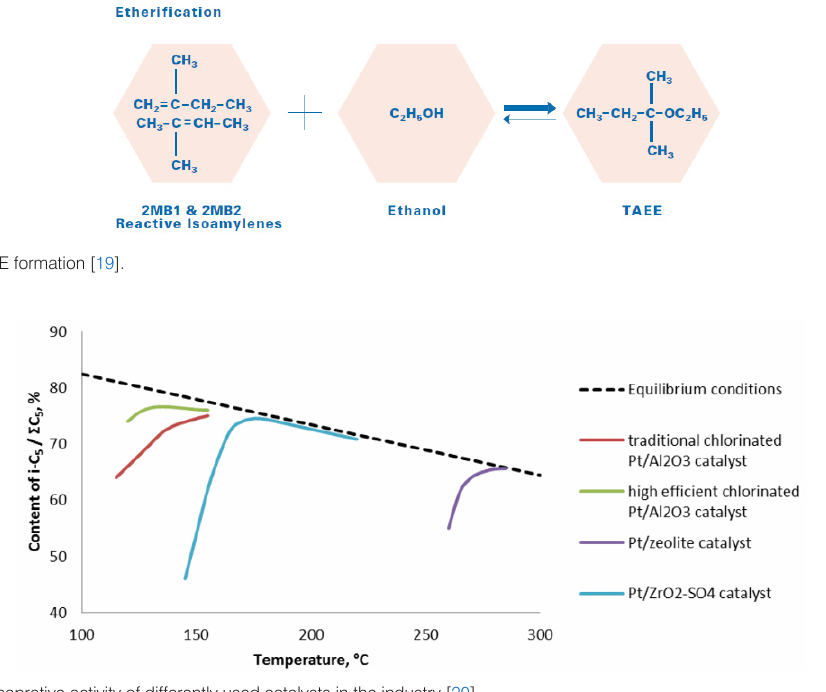
Figure 6. Comaprative activity of differently used catalysts in the industry